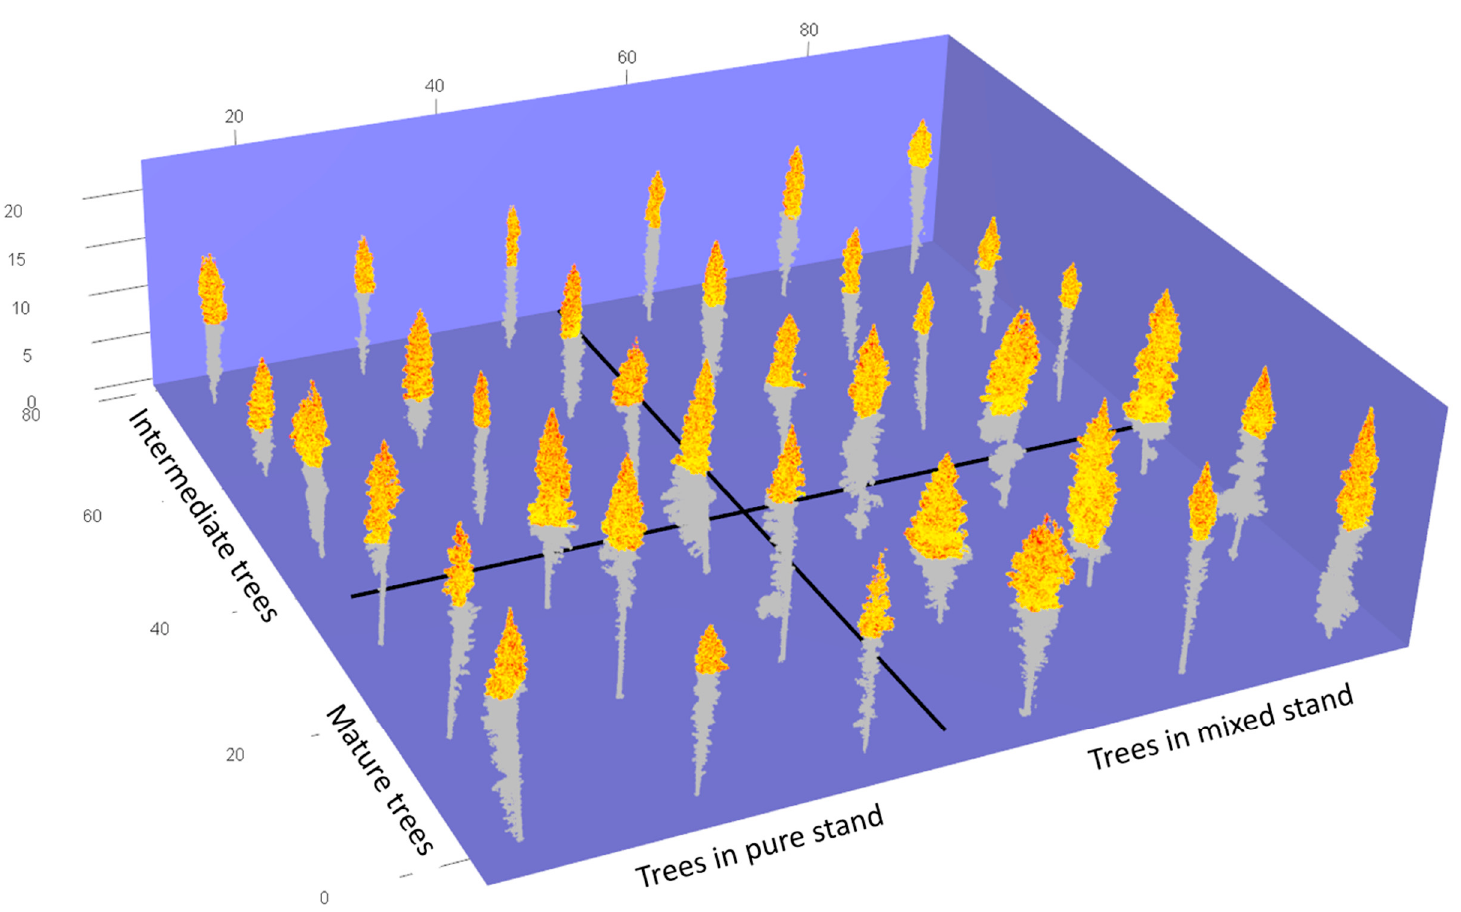
Figure A1. Three dimensional representation of all balsam fir trees (72 trees). The voxels of the crowns are represented with a color gradient from yellow to red for RDIT values (similar to Figure 2).